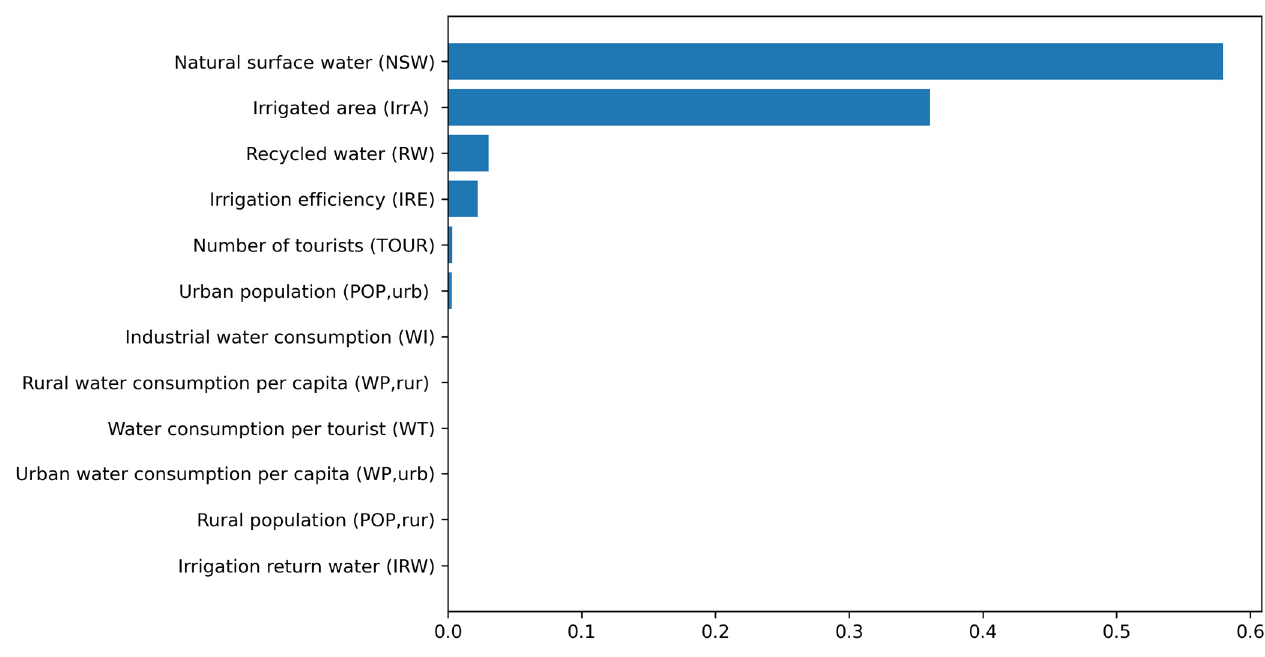
Figure 9. Ranking of the key parameters of the System Dynamics model in the Souss-Massa basin.